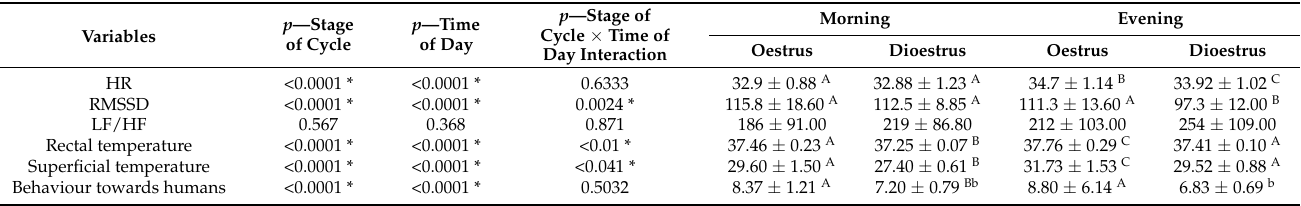
Table 4. p -values of effects (stage of the oestrous cycle, time of day, and interaction) on the traits and means of variables (means ±